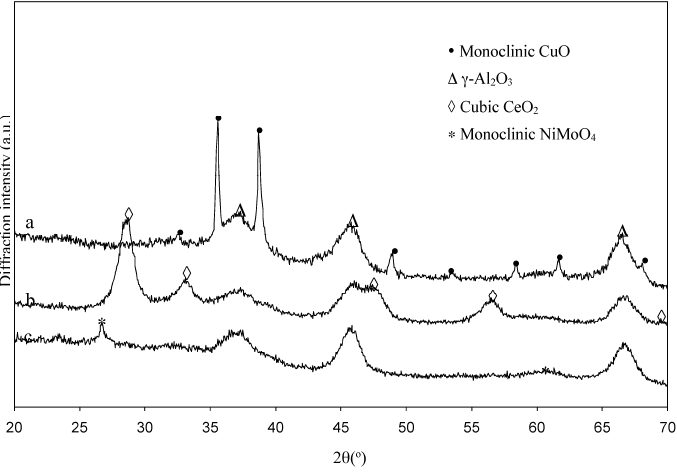
Figure 3. XRD patterns of different catalysts: ( a ) 18 wt. % Ni 0.5 ‐ Cu 0.5 /Al 2 O 3 , ( b ) 18 wt. % Ni 0.5 ‐ Ce 0.5 /Al 2 O 3 , ( c ) 18 wt. % Ni 0.5 ‐ Mo 0.5 /Al 2 O 3 .